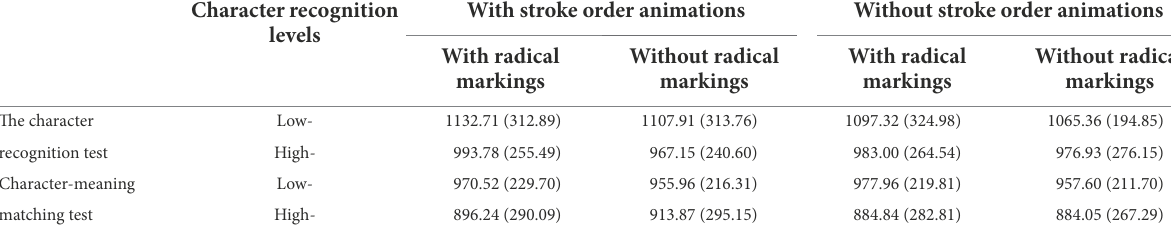
TABLE 4 Mean reaction times (ms) and standard deviation (in parentheses) of the one-week delayed